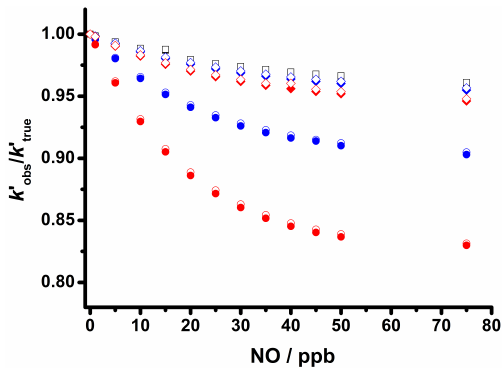
Figure 5. Impact of NO on the ratio of the k (cid:48) fitted to model OH simulations for OH to the k (cid:48) used as input for the model (i.e. OH /k (cid:48) true ) . Black points show results for the equivalent of k (cid:48) observed model simulations with the initial HO 2 concentration set to zero; blue data points show results for model simulations with the initial HO 2 concentration set to 1 × 10 8 cm − 3 ; red data points show re- sults for model simulations with the initial HO 2 concentration set to 2.5 × 10 8 cm − 3 ; circles represent data points with an initial OH concentration of 10 9 cm − 3 ; diamonds represent data points with an initial OH concentration of 10 10 cm − 3 ; filled data points represent simulations with the initial RO 2 concentration set to zero; open data points represent simulations with an initial RO 2 concentration of 1 × 10 10 cm − 3